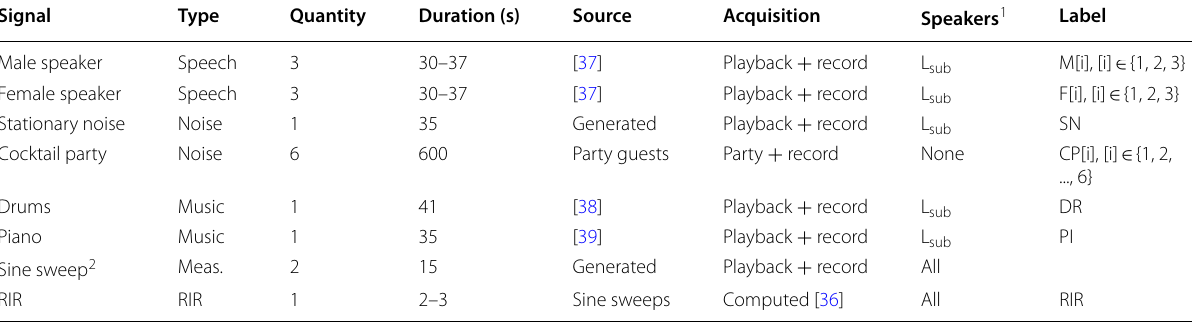
1 The subset L sub includes all speakers in SAL and SL1 to SL8 in the AIL, cf. Fig. 5 and Table 2. 2 The raw sine sweeps are not included in the database and hence do not have a label